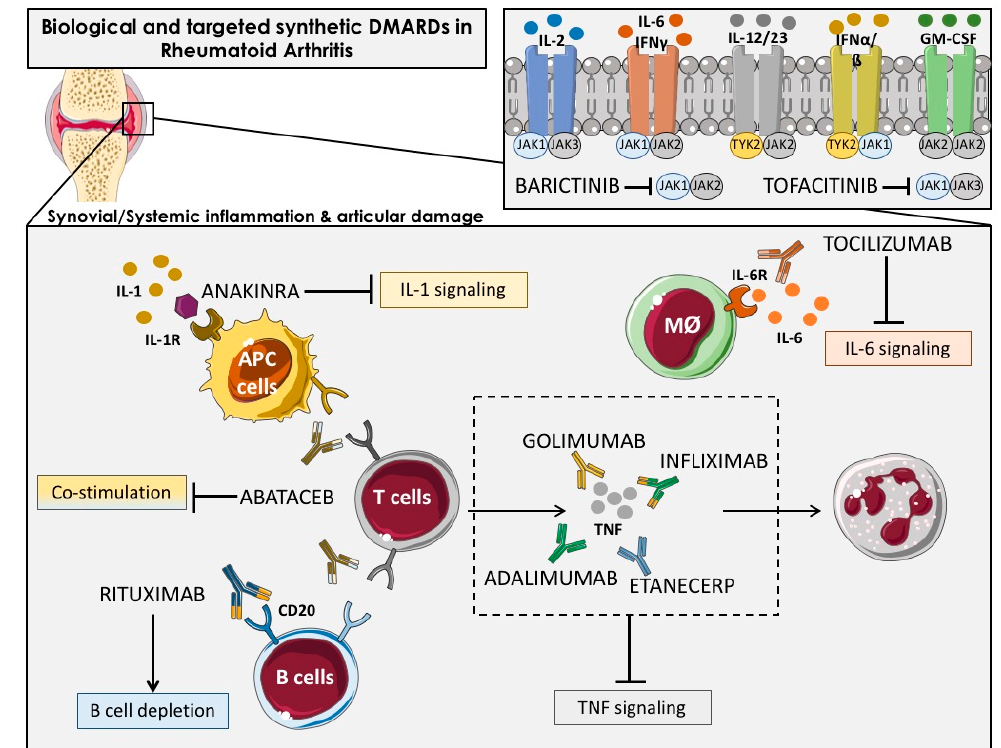
Figure 2. Overview of the main immunologic pathways targeted by the biological and targeted synthetic therapies in rheumatoid arthritis. Simplified description of cytokines and receptors that are targeted by available biologic DMARDs such as: TNF inhibitors (adalimumab, golimumab, infliximab and etanercept), IL-1R antagonist (anakinra), antibody against IL-6R (tocilizumab) and anti-CD20 (rituximab), and targeted synthetic DMARDs, such as Janus kinase inhibitors (anti-JAKs): tofacitinib (JAK1-JAK3 inhibitor) and baricitinib (JAK1–JAK2 inhibitor). APC: Antigen-presenting cells; M ϕ :